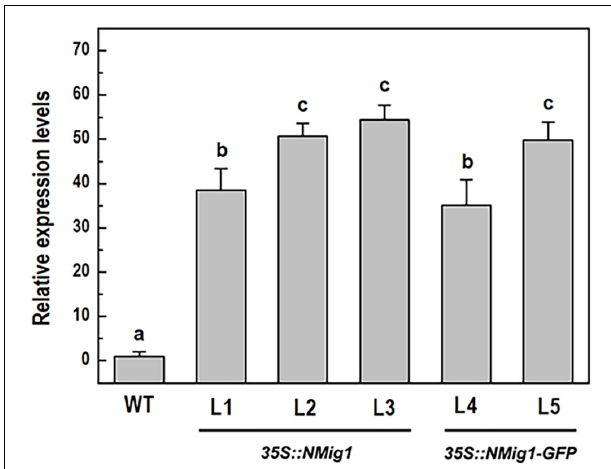
FIGURE 2 | Expression analysis of the NMig1 gene in 10-day-old wild-type seedlings and homozygous transgenic lines overexpressing NMig1 (L1-L5). Expression levels were normalized to those of EF1a and CDKA1;1 , as described in Materials and Methods. Data represents the mean values ± SE from at least three biological replicates. Different lowercase letters indicate statistically significant difference ( p ≤ 0.05).